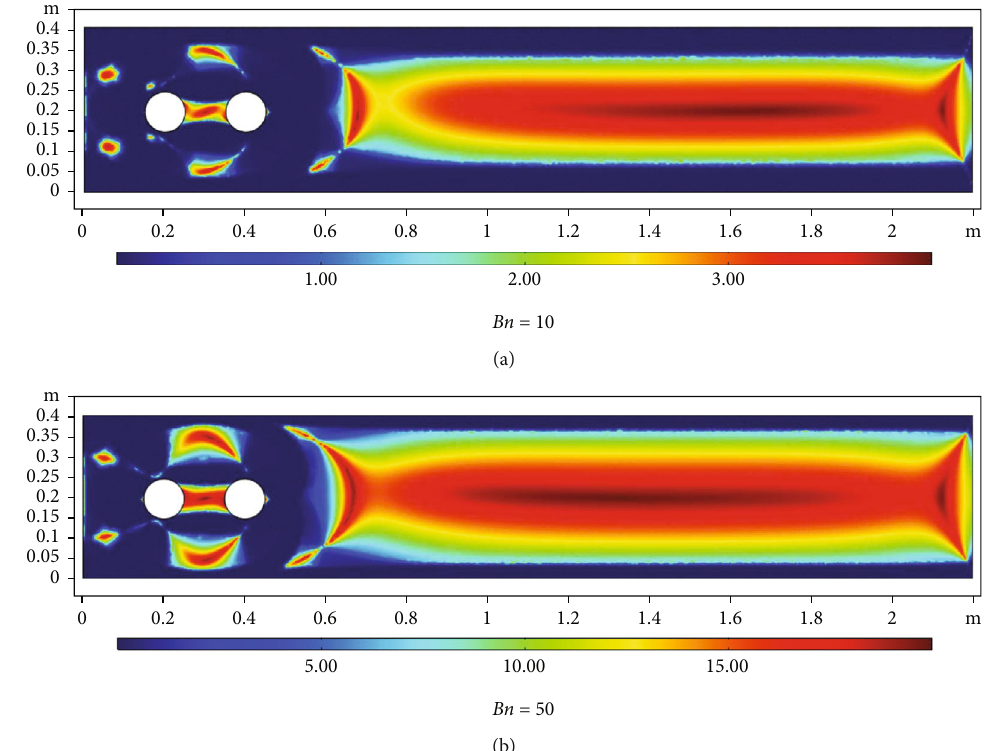
= 0 : 1 and Re = 20 . (a) Bn = 10 . (b) Bn = 50 p